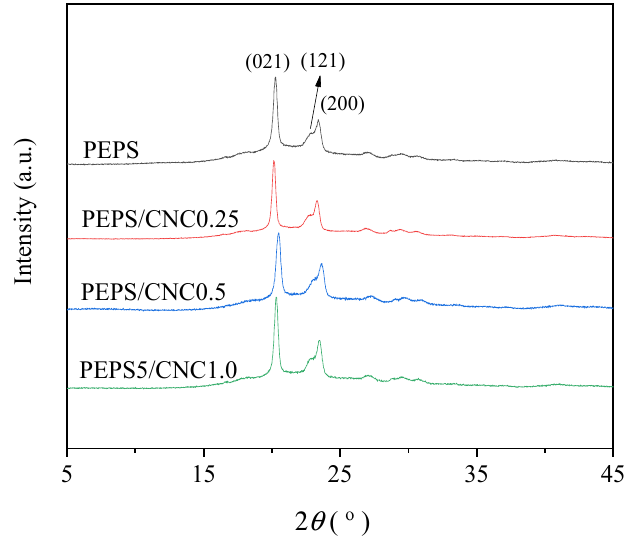
Figure 7. WAXD patterns of PEPS and PEPS/CNC composites.